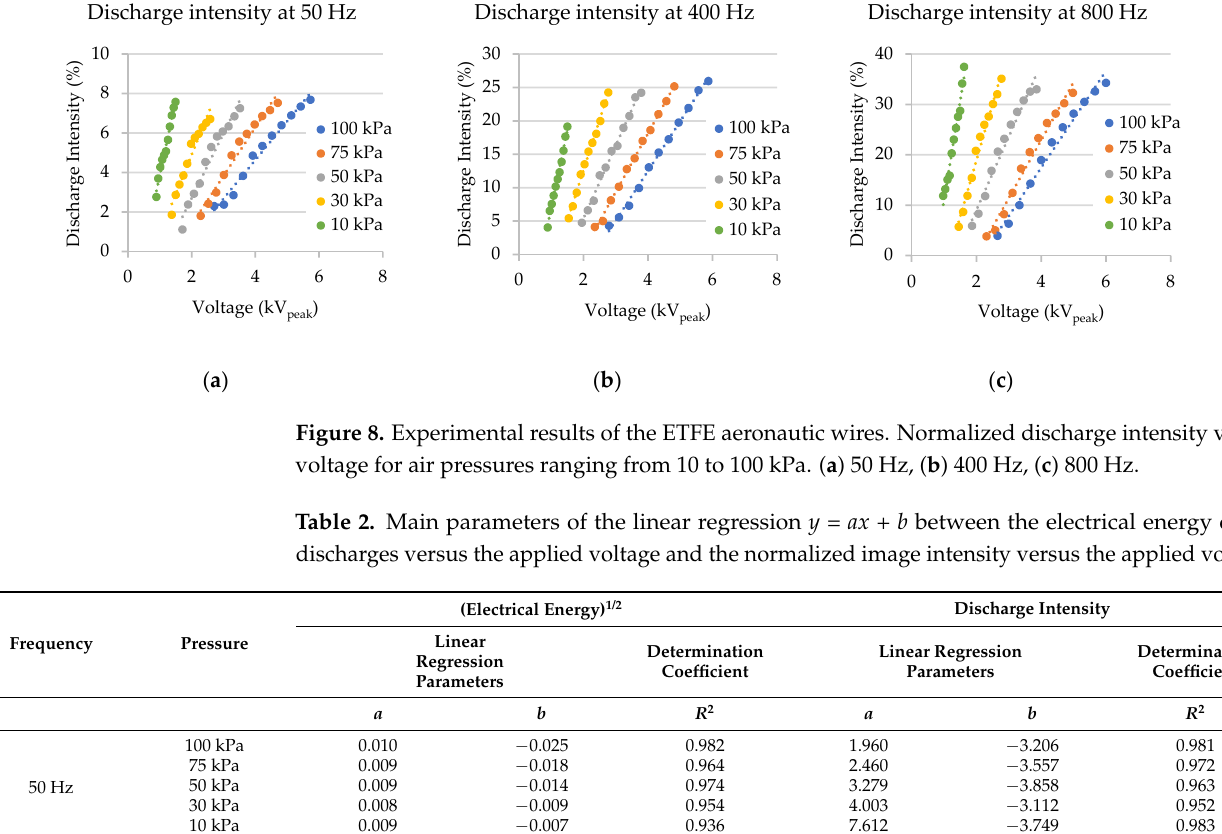
( c ) Figure 7. Experimental results of the ETFE aeronautic wires. Square root of the electrical energy versus voltage for air pressures ranging from 10 to 100 kPa. ( a ) 50 Hz, ( b ) 400 Hz, ( c ) 800 Hz. Figure 8 summarizes the results of the normalized intensity of the discharges, whose values were obtained from the digital images generated by the image sensor after a suita- ble postprocessing described in Section 2.1. The results presented in Figure 8 clearly show that the normalized intensity of the discharges increases linearly with the applied voltage. Results presented in Figure 8 also show that for a given applied voltage, discharge inten- sity detected by the image sensor increases when reducing the pressure. They also show that the minimum voltage at which discharge activity is detected by the image sensor decreases with the ambient pressure.